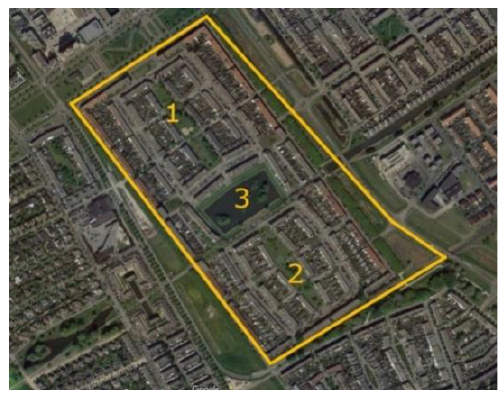
Figure 4. The three green spaces on which our project focuses (Google Maps).